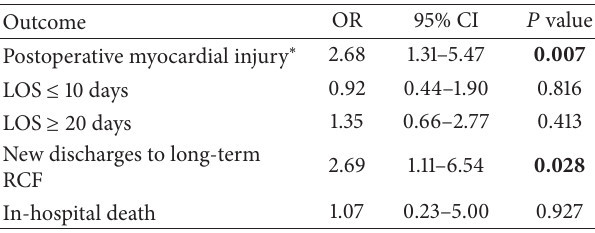
Table 6: Effect of history of stroke on short-term outcomes in older hip fracture